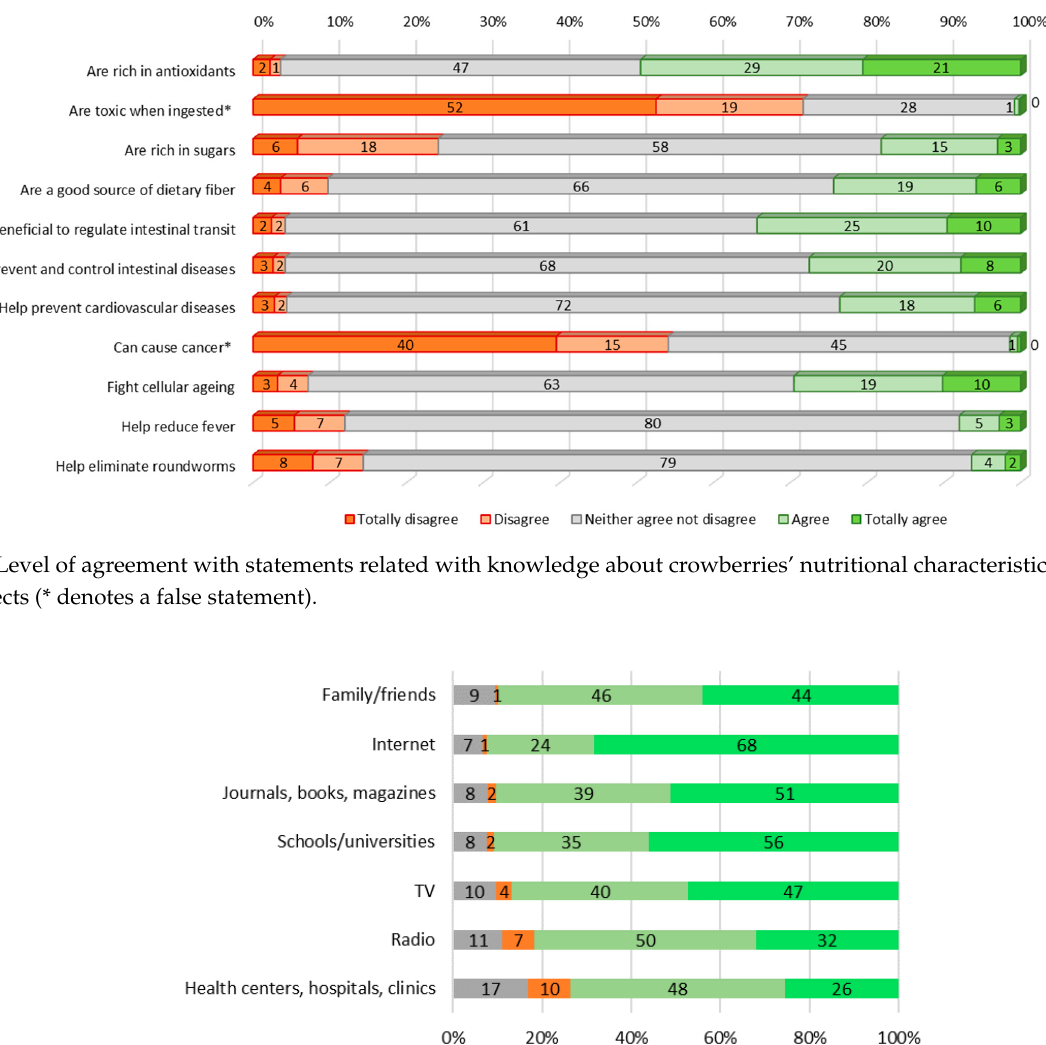
Figure 3. Level of agreement with statements related with knowledge about crowberries’ nutritional characteristics and health effects (* denotes a false statement).